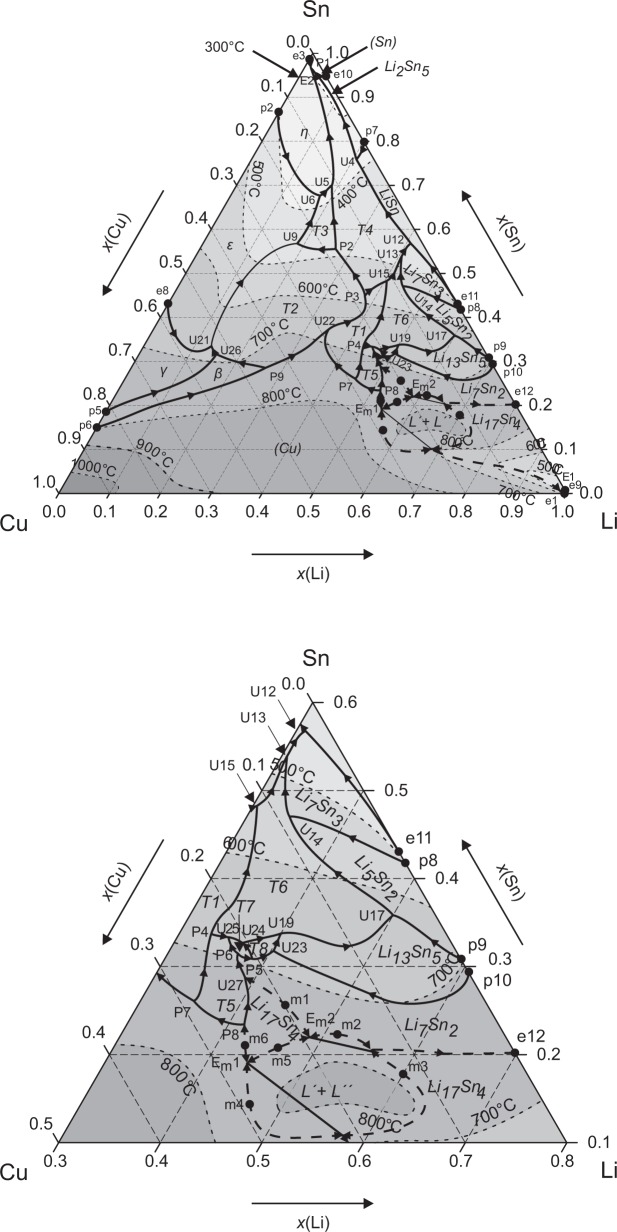
Liquidus projection including section of Li-rich corner.